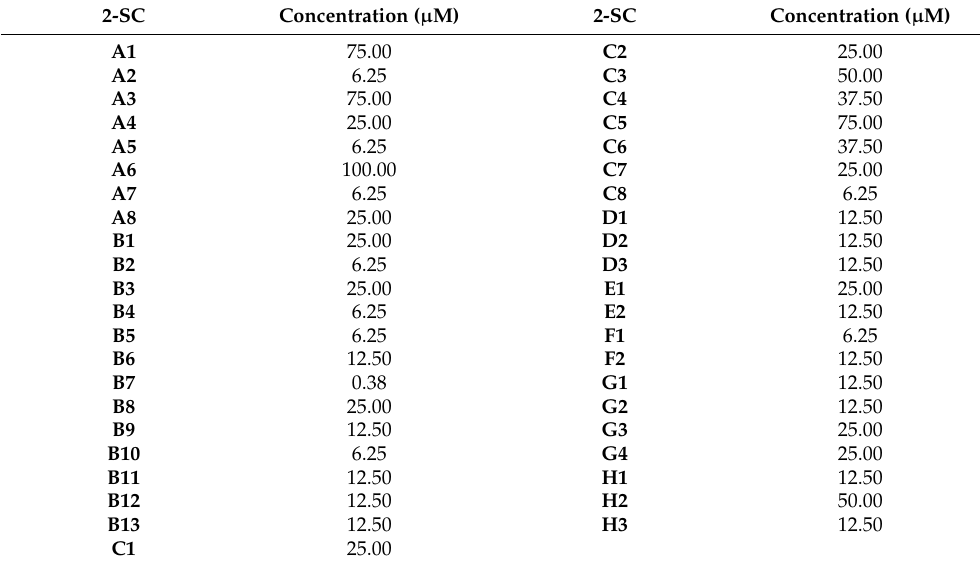
Table 1. Higher 2-SC concentrations ( µ M) that did not affect human neutrophils’ viability, according to the annexin V/PI assay.